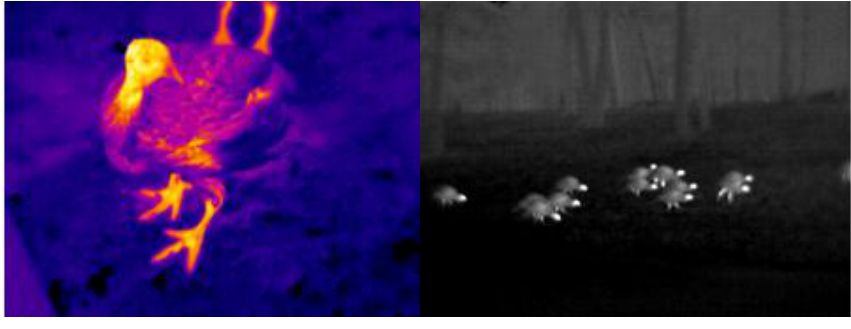
Figure 4. ( Right ) Infrared image of a Turkey, ( Left ) Detectable hotspots of turkeys for analyzing crowd behavior (Both images are provided by The Snell Group, http://www.thesnellgroup.com